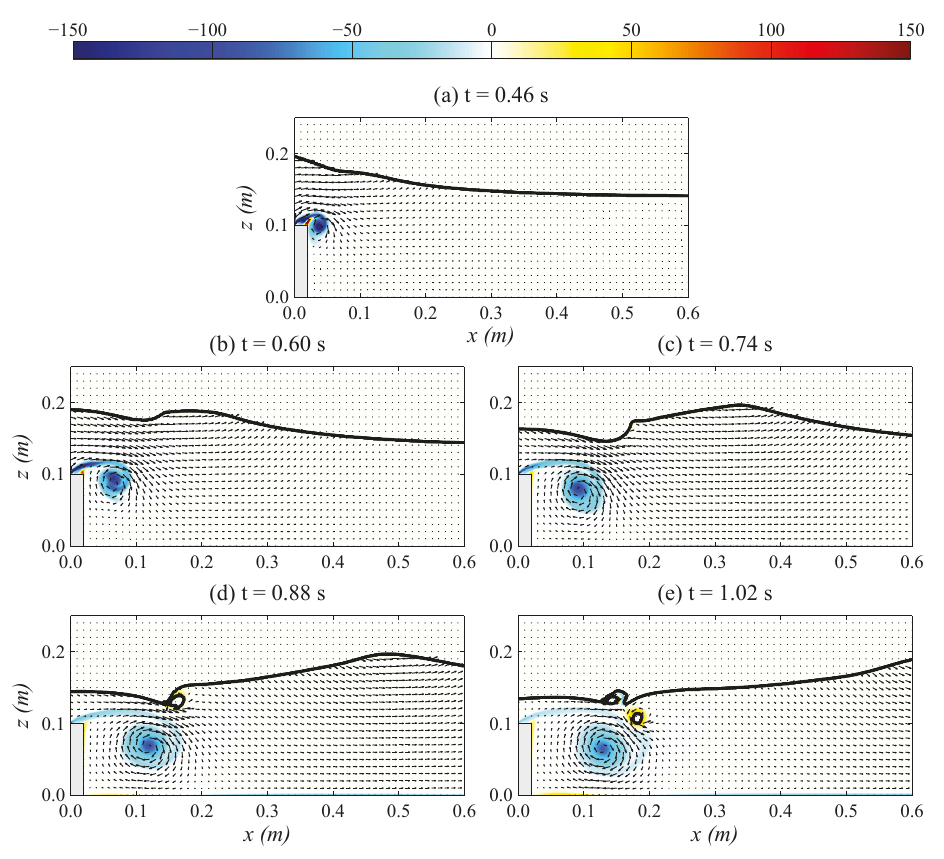
Figure 4. Simulated evolutions of the free surface elevation, velocity and vorticity (unit: s − 1 ) (color map) fields for the case of D = 0.00 m at five time instants: ( a ) t = 0.46 s; ( b ) t = 0.60 s; ( c ) t = 0.74 s; ( d ) t = 0.88 s; ( e ) t = 1.02 s.